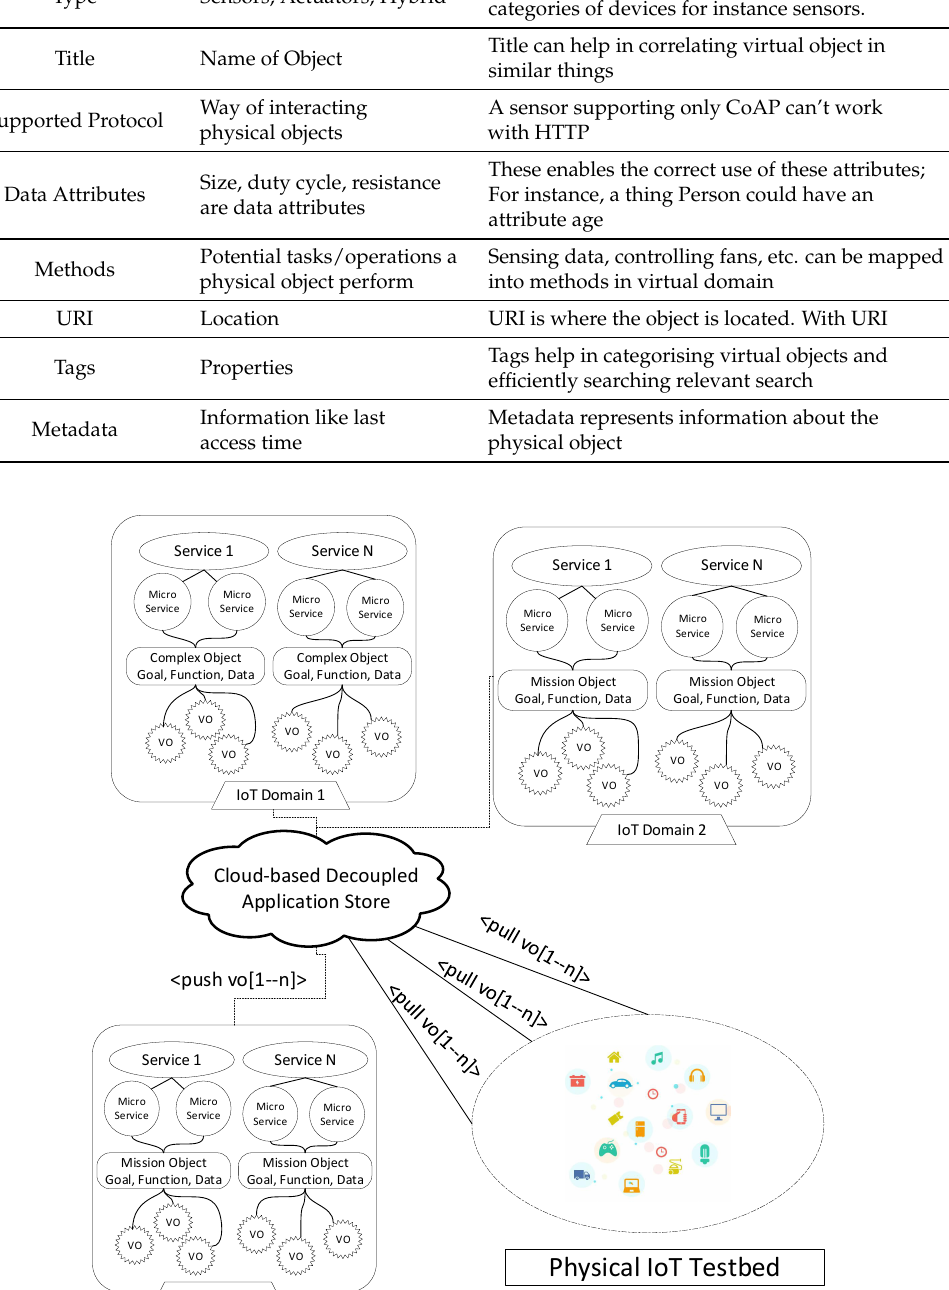
Figure 1. Overview architecture of the proposed application